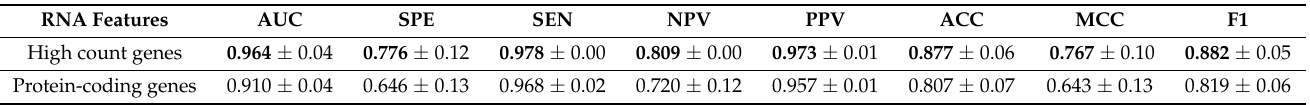
Table 2. 12-fold crossvalidation classification performance with a resolution of 350 × 350 high-expression and protein-coding genes RNA